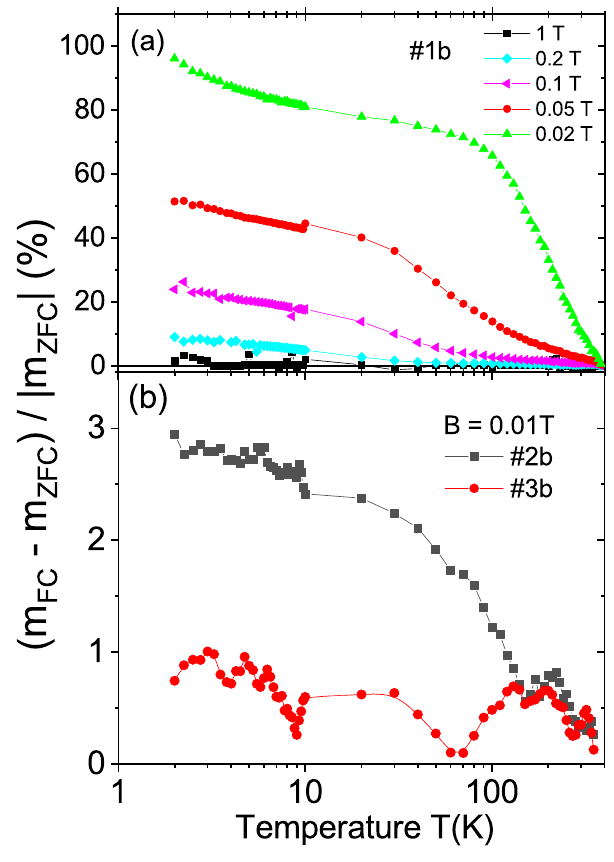
Figure 7. Temperature dependence of the relative difference 100 [ m F C ( T ) − m Z FC ( T )] / | m Z FC ( T ) | for the CVD samples: ( a ) #1b at five different applied fields and ( b ) #2b and #3b at a field of 0.01